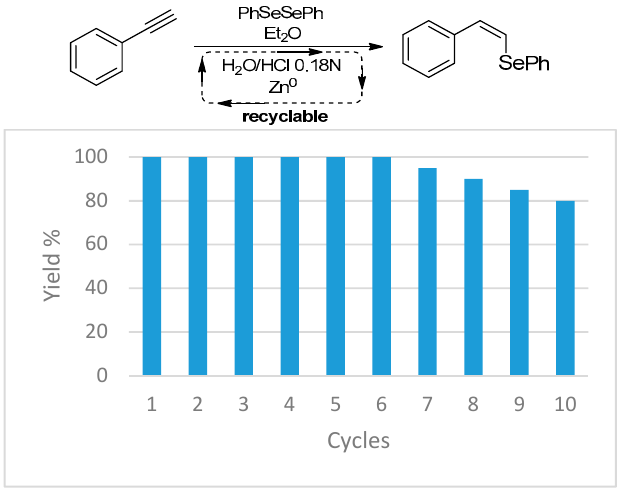
Figure 6. Yield of the hydrochalcogenation of phenylacethylene for 10 cycles, reusing water and unreacted zinc.